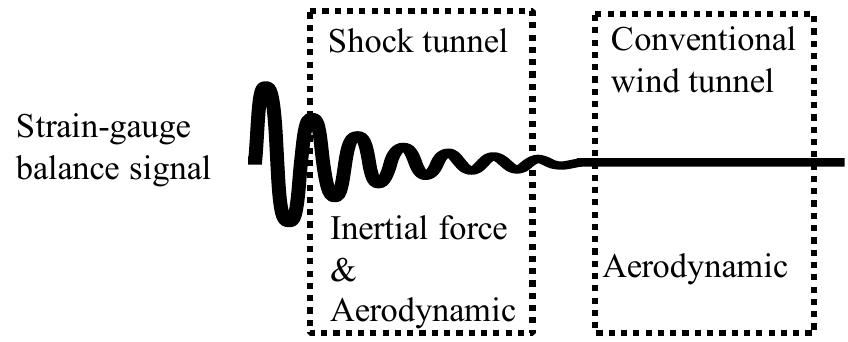
Figure 1. Balance signal processing in a shock tunnel and the conventional wind